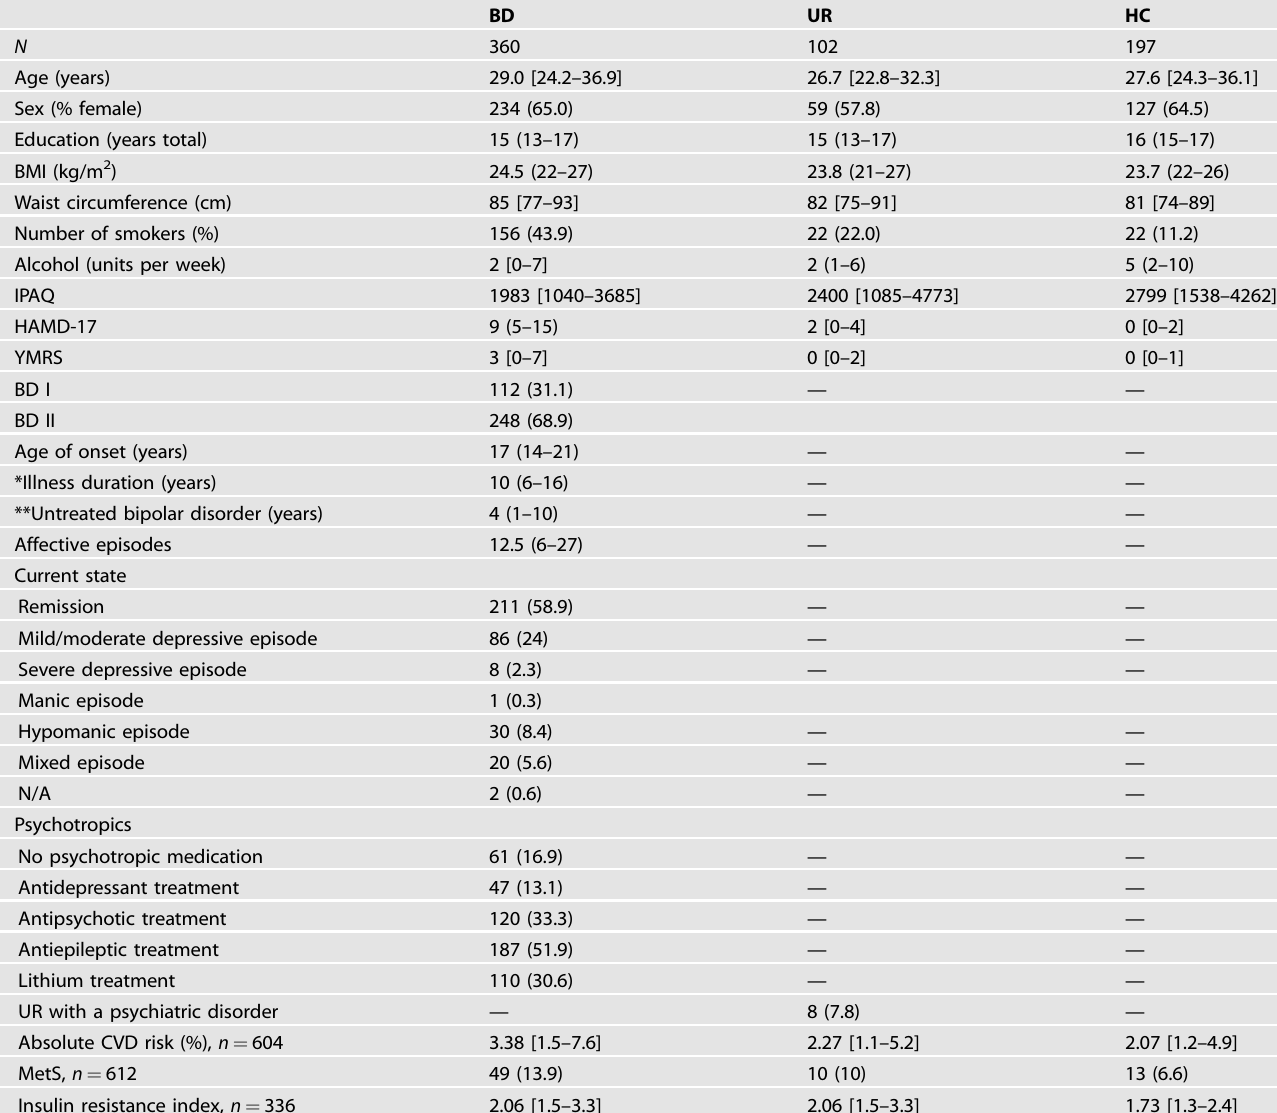
Table 1. Demographic and clinical variables in patients with newly diagnosed bipolar disorder (BD), their unaffected relatives (UR), and healthy controls individuals